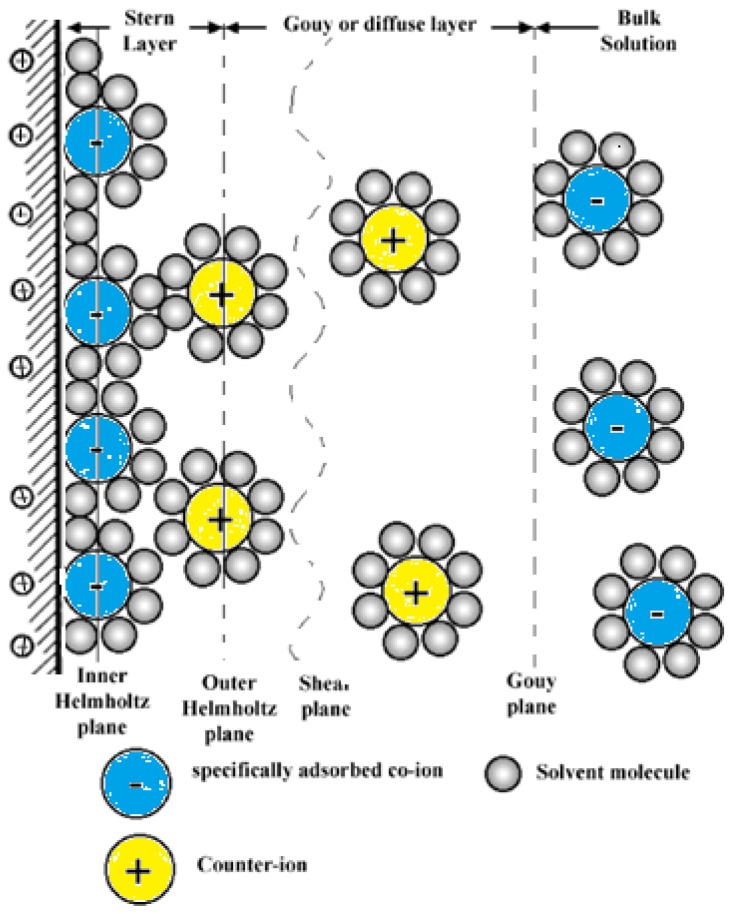
Schematic representation of the electric double layer (EDL). Overall model of the double-layer showing solvent molecules, counterions and specifically adsorbed co-ions.